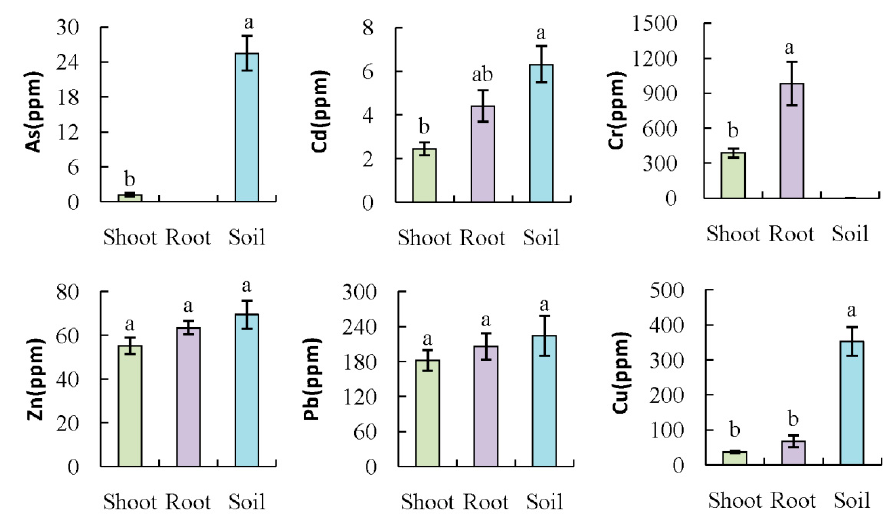
Figure 2. Heavy metal allocation in shoot, root, and soil of B. ischaemum. Different letters indicate significant differences according to Duncan's test ( P < 0.05) (a > ab > b > c).